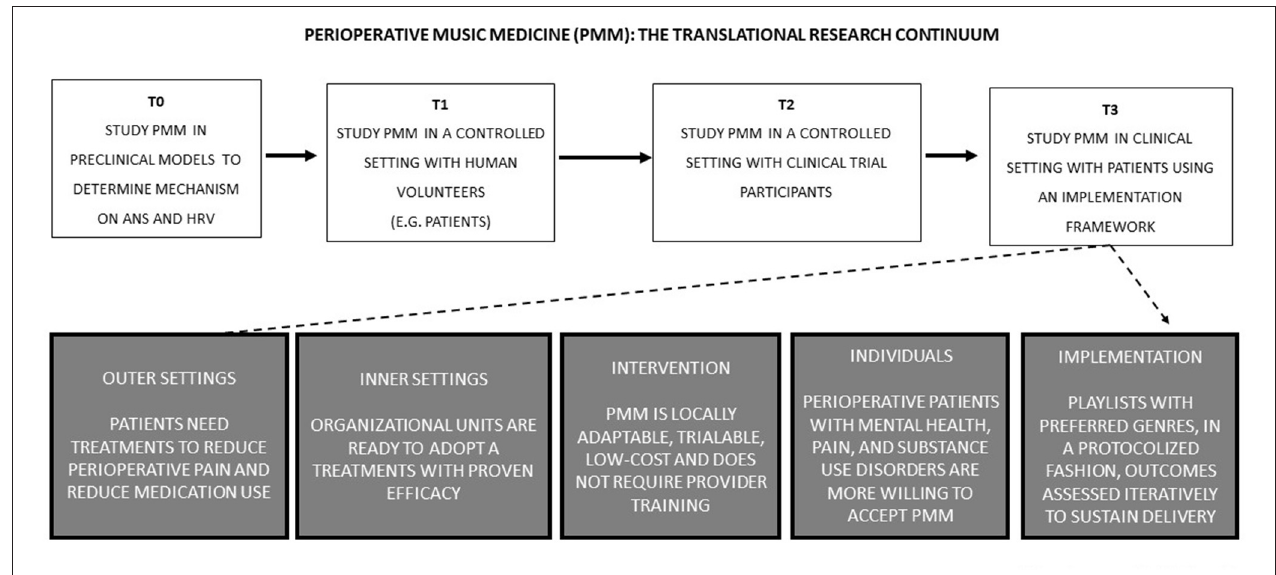
FIGURE 1 | Perioperative Music Medicine (PMM) translational research continuum. Schematic diagram of translational research on PMM for the implementation of new more effective treatments based on mechanistic